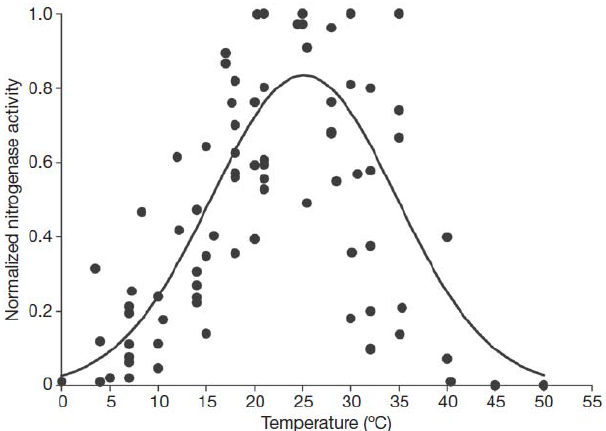
Figure 1. Temperature dependence of terrestrial nitrogenase activ- ity. Data are normalized to the maximal activity observed for each study, including those from temperate to tropical latitudes, and dif- ferent strains and species of N-fixing organisms (from Houlton et al.,